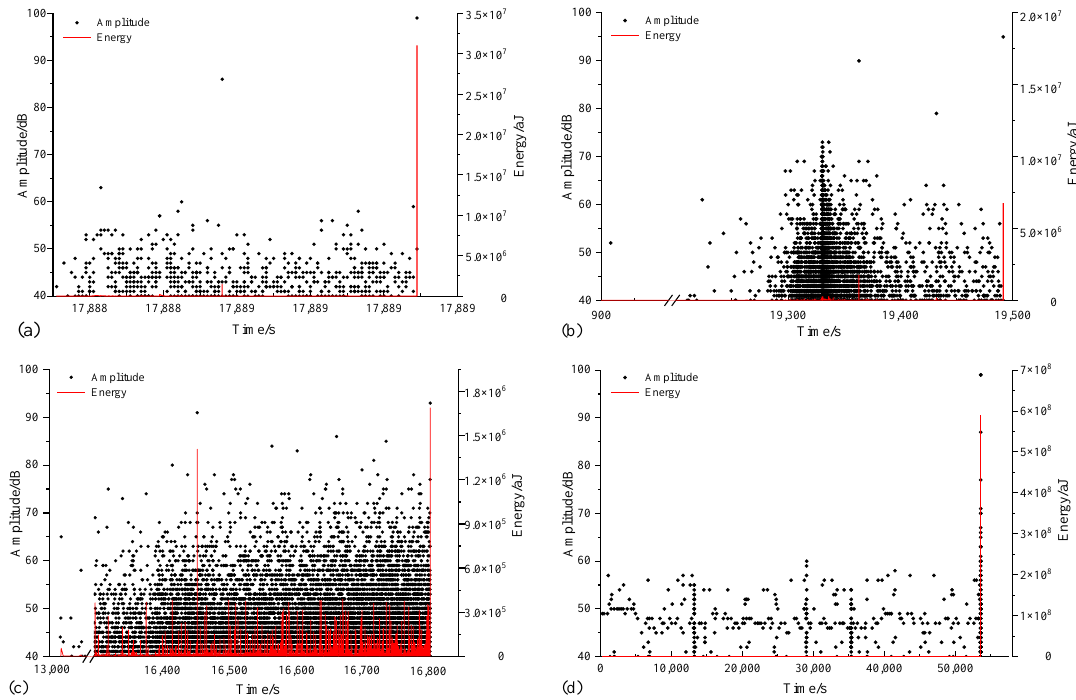
Figure 4. Variation of amplitude and energy of the AE hit signals with respect to time. ( a – d ) are red sandstone, marble, granite and limestone, respectively.